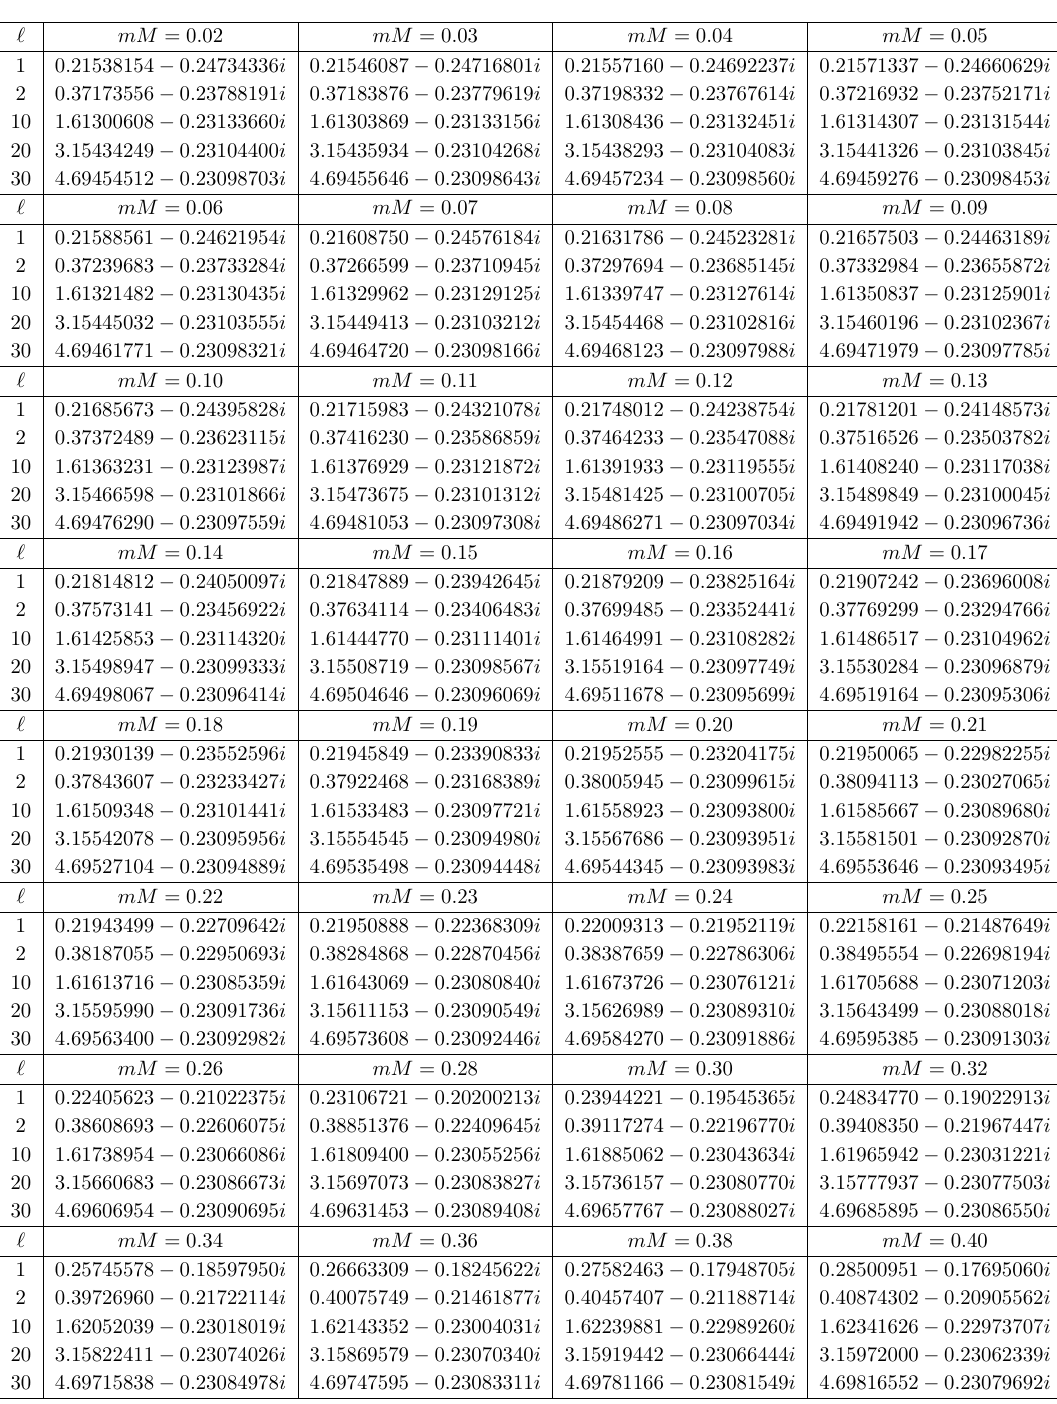
Table 5 . Photon sphere modes for the (cid:12)rst overtone number ( n PS = 1) for massive scalar (cid:12)elds with ‘ = 1 ; 2 ; 10 ; 20, and 30 in the background of a Schwarzschild-de Sitter black hole with M 2 (cid:3) = 0 :